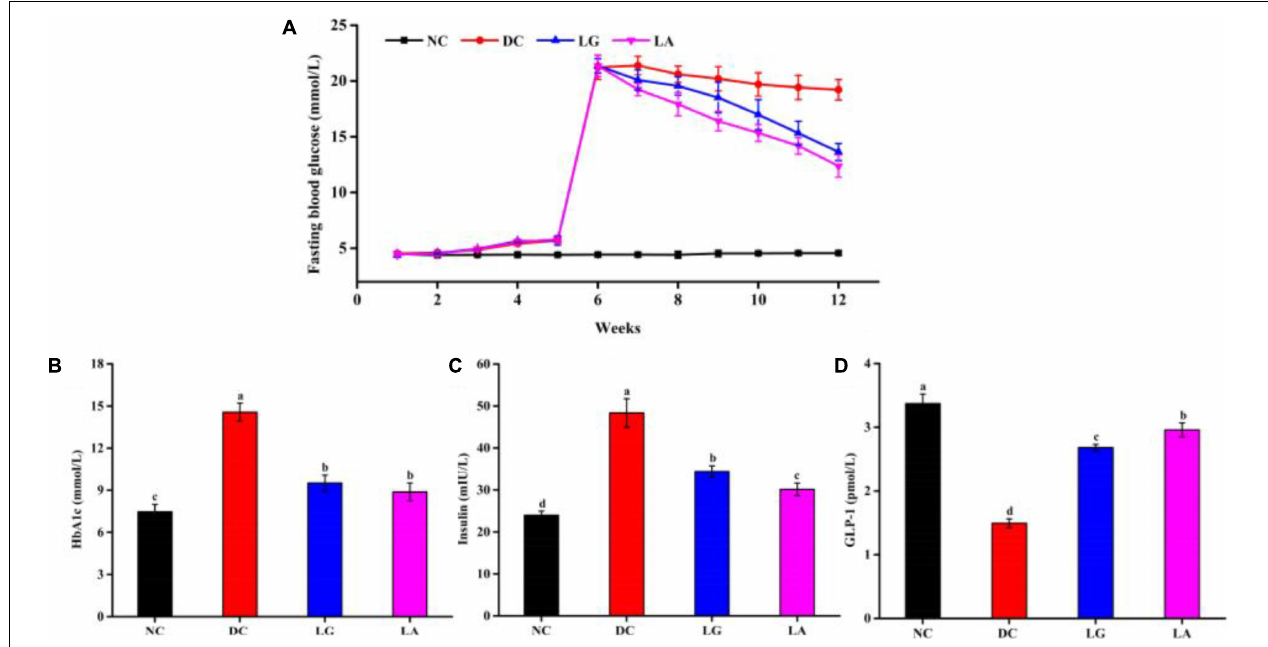
FIGURE 5 | Effects of probiotics on fasting blood glucose (A) , serum HbA1c (B) , insulin (C) , and GLP-1 (D) levels. NC, normal control group; DC, diabetic control group; LG, DC plus L. rhamnosus GG; LA, DC plus L. acidophilus KLDS1.0901. Data are expressed as the mean ± SD ( n = 8 independent experiments). Values with different letters are significantly different ( p <